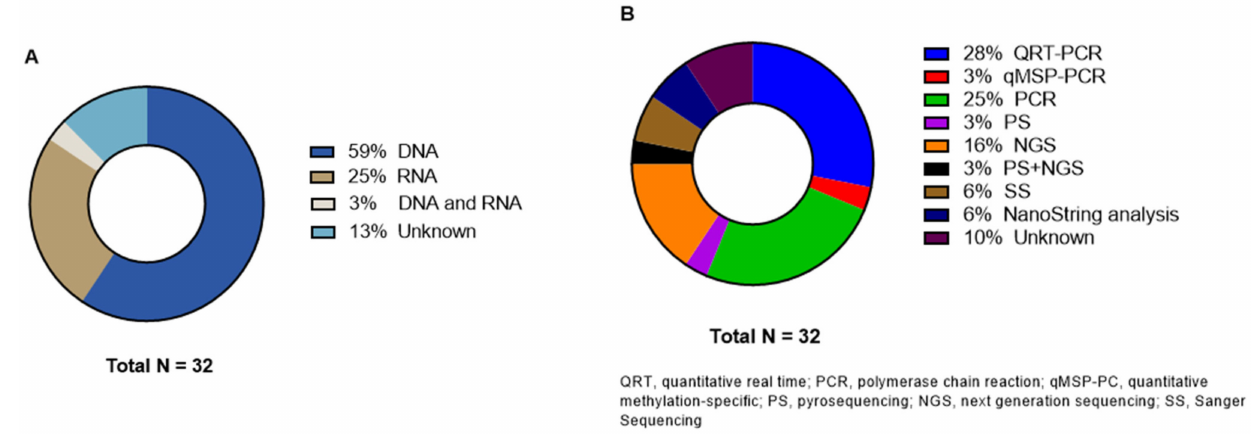
Figure 5. Distribution of ( A ) genetic analysis level and ( B ) different molecular